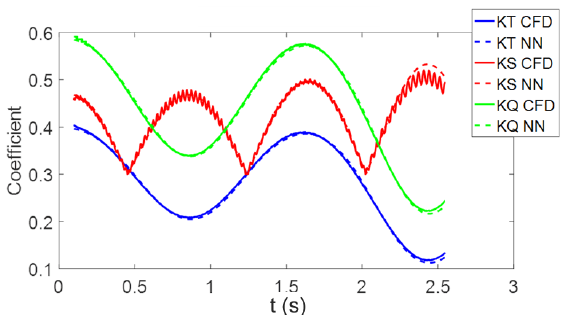
Figure 8. Open water coefficients for the test data set comparing CFD to the neural network.